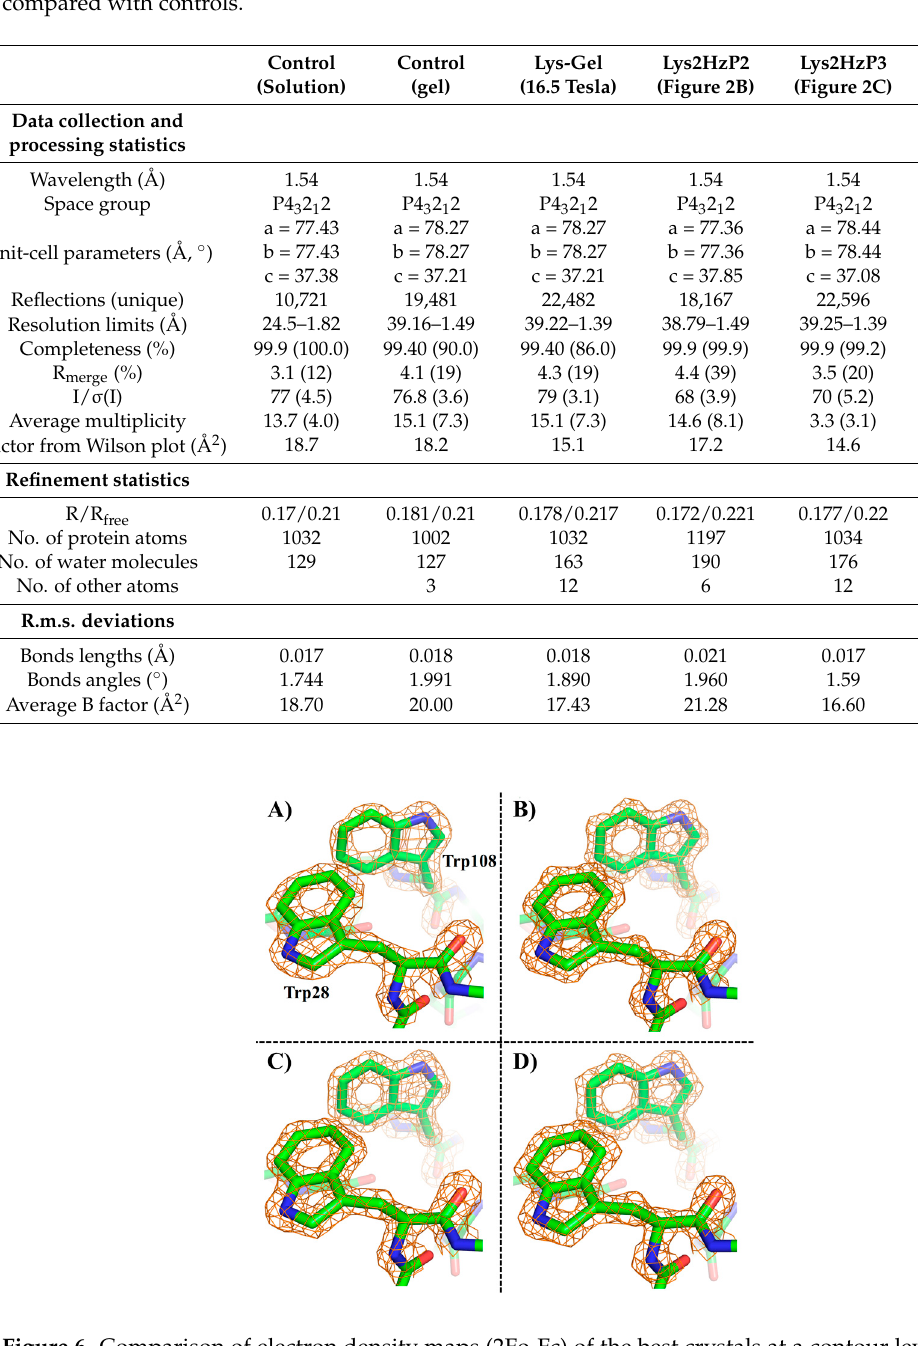
Table 1. Data collection and refinement statistics of the best crystals obtained by using these methods compared with controls.